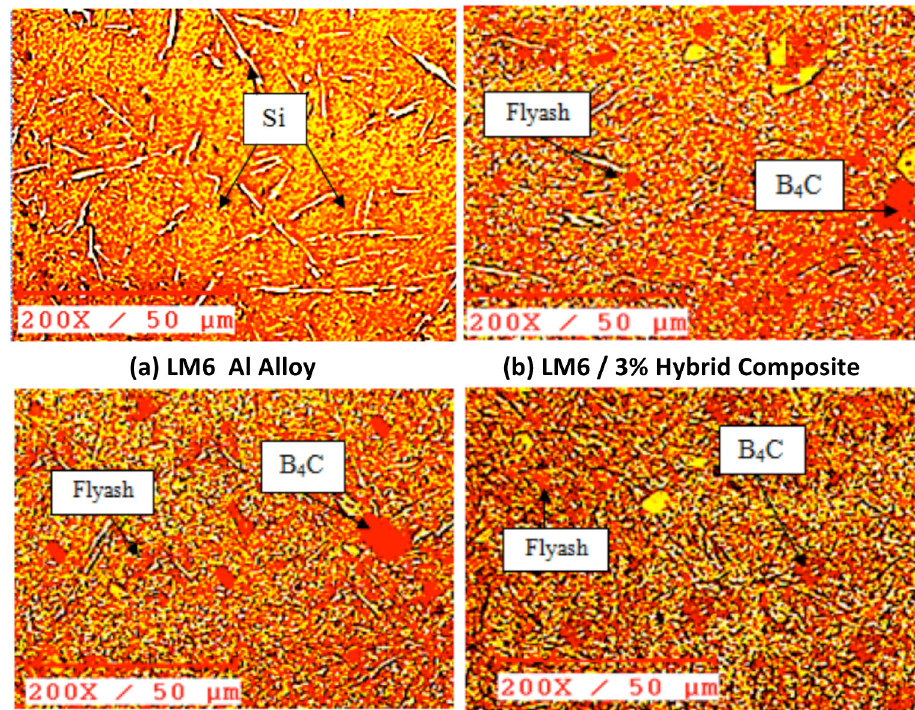
Fig. 7. (a – d) Micrographs of LM6/B 4 C/Fly ash hybrid